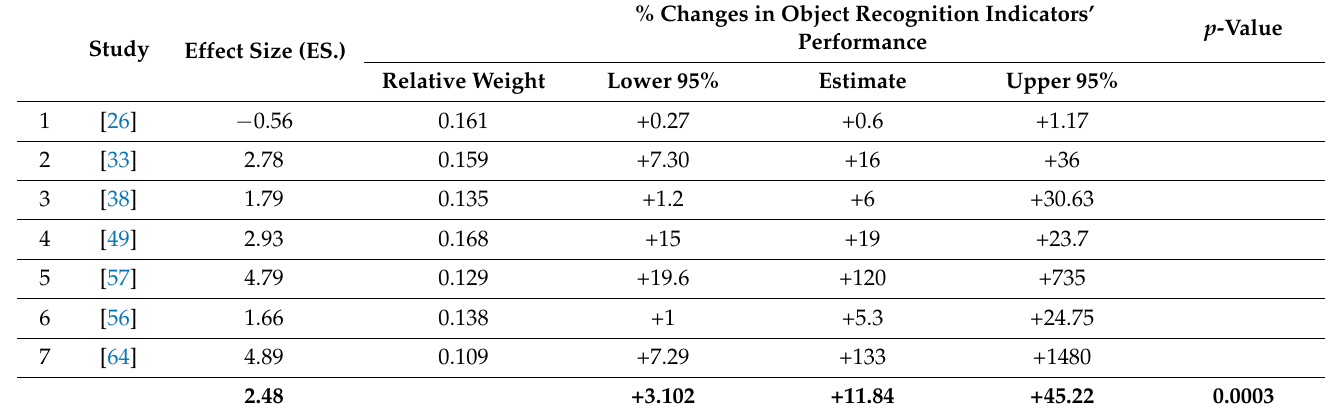
Table 7. Results from Random effect meta-analysis model.